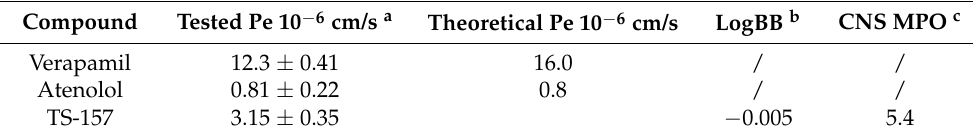
Figure 2. Cell viability of N1E-115 treated with TS-157 at concentrations from 0.1 µ M to 100 µ M by MTT assay. Data expressed as mean ± SEM. Table 1. Evaluation of membrane permeability of TS-157.